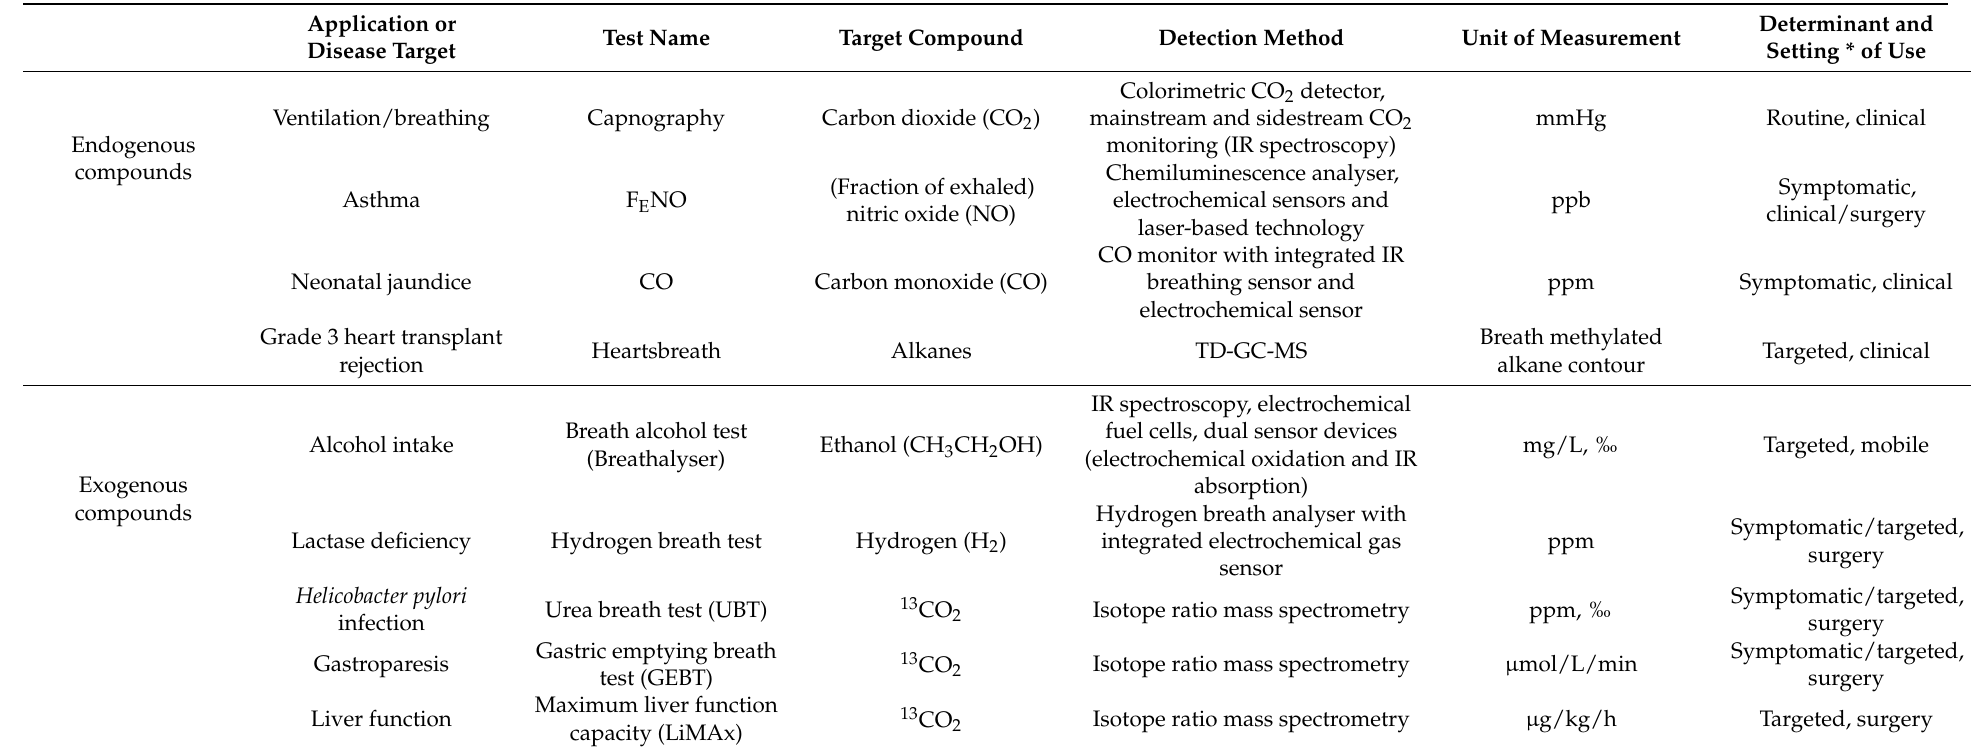
Table 1. Current established/approved breath-based tests that utilise endogenous or exogenous gas-phase